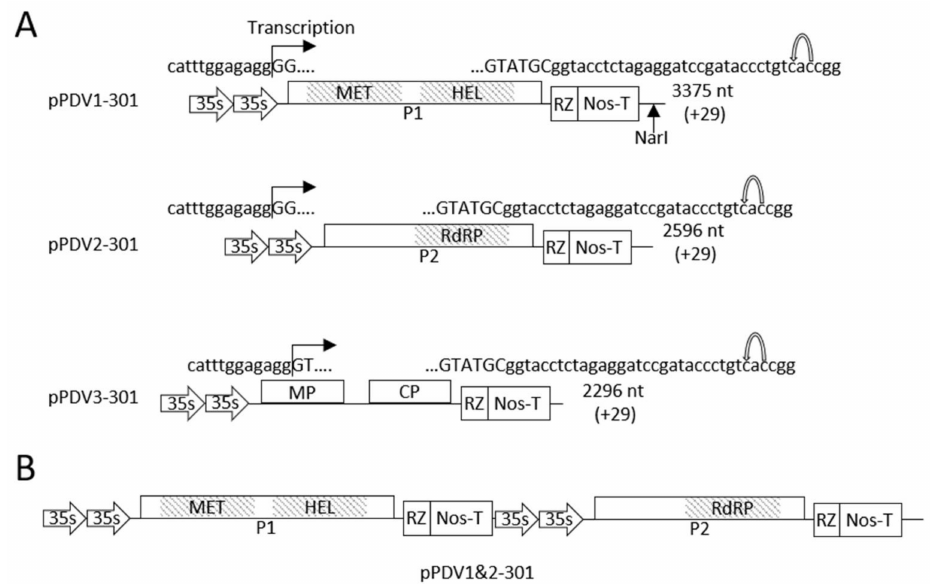
Figure 2. Schematic diagram of the infectious clone of PDV for in plant studies. ( A ) Tripartite infectious clone of PDV is comprised of cDNAs of each PDV genomic RNA separately inserted into the vector pCB-Rz. ( B ) cDNAs of PDV genomic RNA fragments 1 and 2 were combined into a single vector to increase the infectivity rate of the PDV infectious clone. Single black lines and lined boxes represent noncoding and coding regions of each RNA fragment, respectively. The protein encoded by each coding region is labelled: P1 (replicase), P2 (RdRp), MP and CP. Identified functional domains of proteins are shown as grey boxes. Transcription start sites are shown at the 5 (cid:48) end of each construct by a bent arrow following the promoter (arrows containing “35 s”) sequence. At the 3 (cid:48) sequence the uppercase and lowercase letters represent the 3 (cid:48) sequence of viral RNA and the non-viral sequence of the hammerhead ribozyme (box containing “RZ”), respectively. The bent arrow at the 3 (cid:48) end indicates the self-cleavage site of the ribozyme. The nucleotide length of RNA1, RNA2 and RNA3 is shown to the right with the number of additional nucleotides after ribozyme self-cleavage provided in parentheses. The single Nar I restriction enzyme recognition sequence is shown in pPDV1-301 which was used for the integration of the cDNA corresponding to the viral genomic RNA2 resulting in the construction of